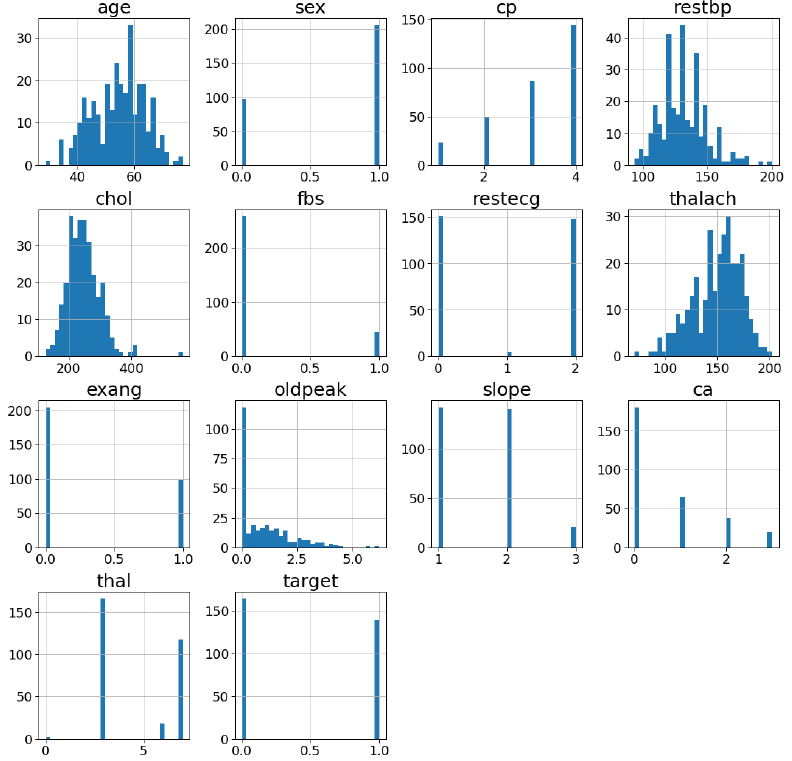
Figure 2. Histogram: A visual representation of the distribution of the Cleveland dataset.